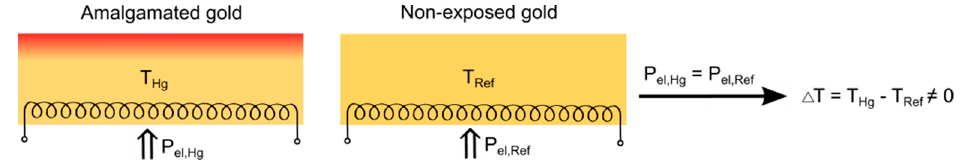
Figure 1. Schematic of the measuring principle: the temperature difference between an amalgamated gold film and a non-exposed gold film is a measure for the mercury concentration at a given exposition time, when heating both films with identical heating